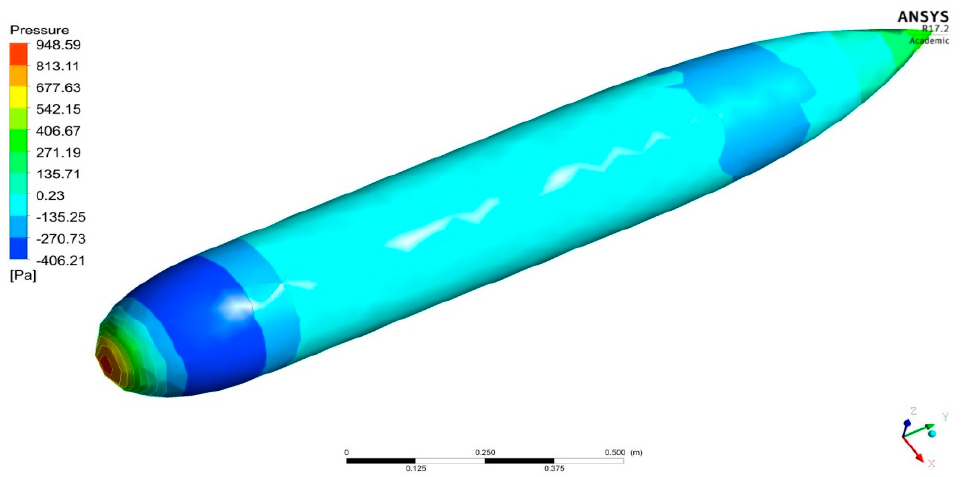
Figure 10. A typical representations of hydrodynamic pressure variations on the fuselage model— Validation study.